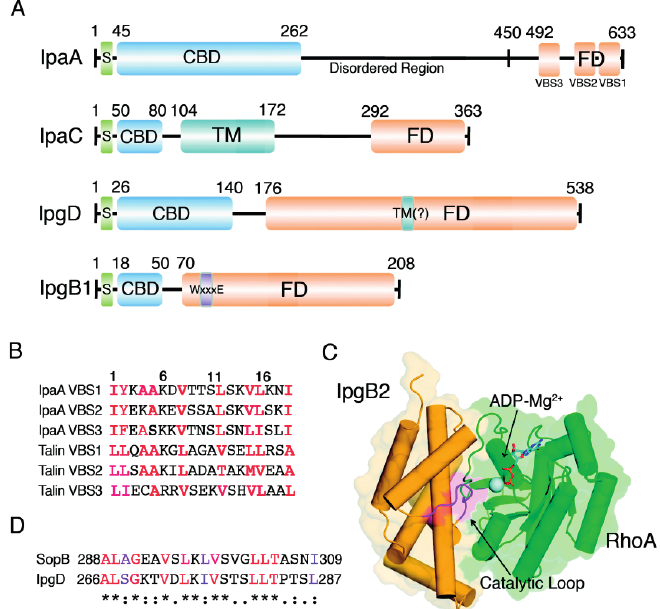
Figure 3. Primary and tertiary structures of Shigella invasins. ( A ) Schematic diagrams of the domain organizations of Shigella invasins for which tertiary structural information is not yet available. S, signal sequence; CBD, chaperone-binding domain; FD, functional domain; TM, transmembrane domain; ( B ) Sequence alignment of selected VBSs. Conserved amino acid residues important for the recognition of Vh1 are red. The numbers at the top of the alignments represent the amino acid positions of VBSs; ( C ) Crystal structure of IpgB2 in complex with RhoA (PDB entry: 3LW8). The catalytic loop is in magenta; ( D ) Sequence alignment of putative TM domains of SopB and